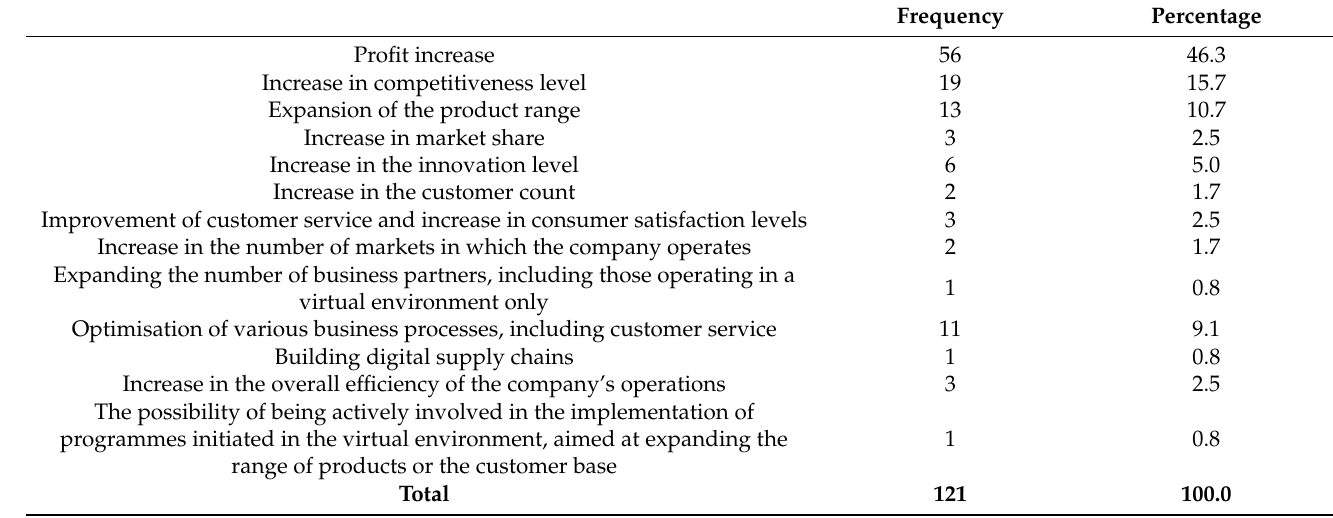
Table 6. The benefits resulting from the implementation of DTPs. Reprinted with permission; 2021,